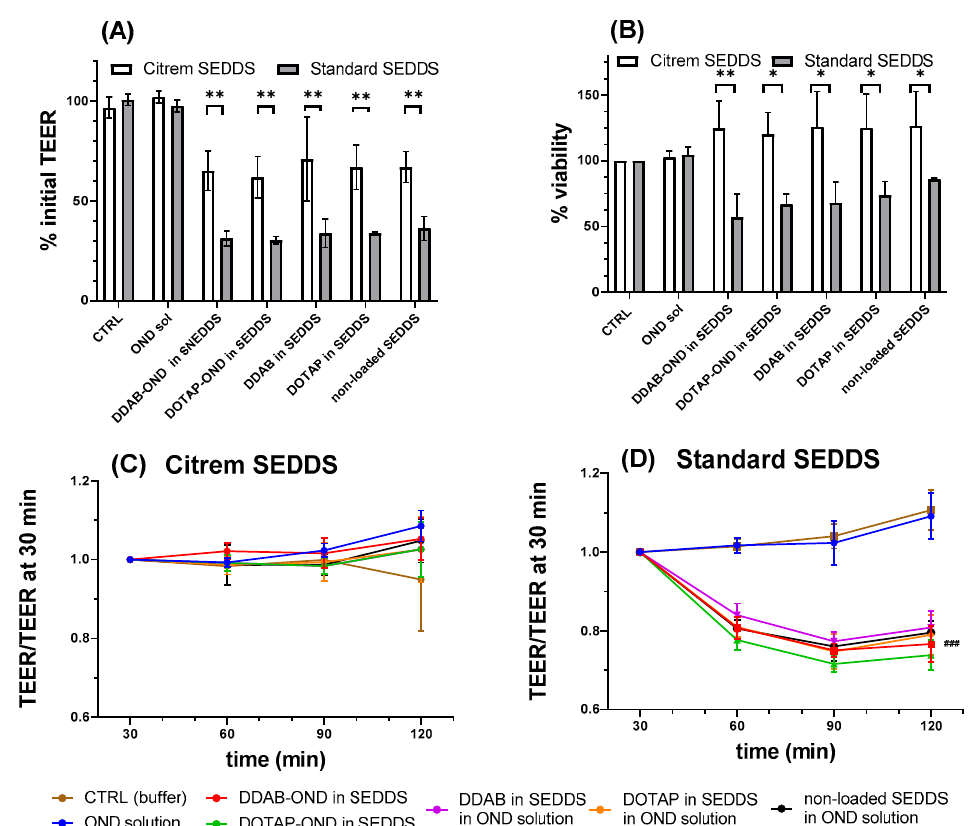
Figure 8. ( A ) Percent of initial transepithelial electrical resistance (TEER) measured by Endohm chamber after 120 min of incubation in both Citrem and Standard SEDDS. ** denotes a significant difference of TEER decline ( p < 0.01) between the Citrem and Standard SEDDS. All SEDDS-incubated cells showed significantly lower TEER relative to the respective CTRL (buffer) and OND solution. ( B ) Percent of viability by lactate dehydrogenase (LDH) assay after 120 min of incubation with Citrem and Standard SEDDS. * and ** denote significant differences in the viability between different SEDDS (* p < 0.05 and ** p < 0.01). ( C , D ) Relative TEER values measured by chopstick electrodes at 37 °C for Citrem SEDDS ( C ) and Standard SEDDS ( D ). ( D ) ### represents a significant difference of the relative TEER values of SEDDS-treated cells relative to the CTRL and OND solution ( p < 0.001). Results are presented as mean ± SD ( n = 5 to 6). Table 8. Transported OND accumulated in the basolateral compartment after 120 min presented as the total mass (pmol) and % of the initial apical mass.